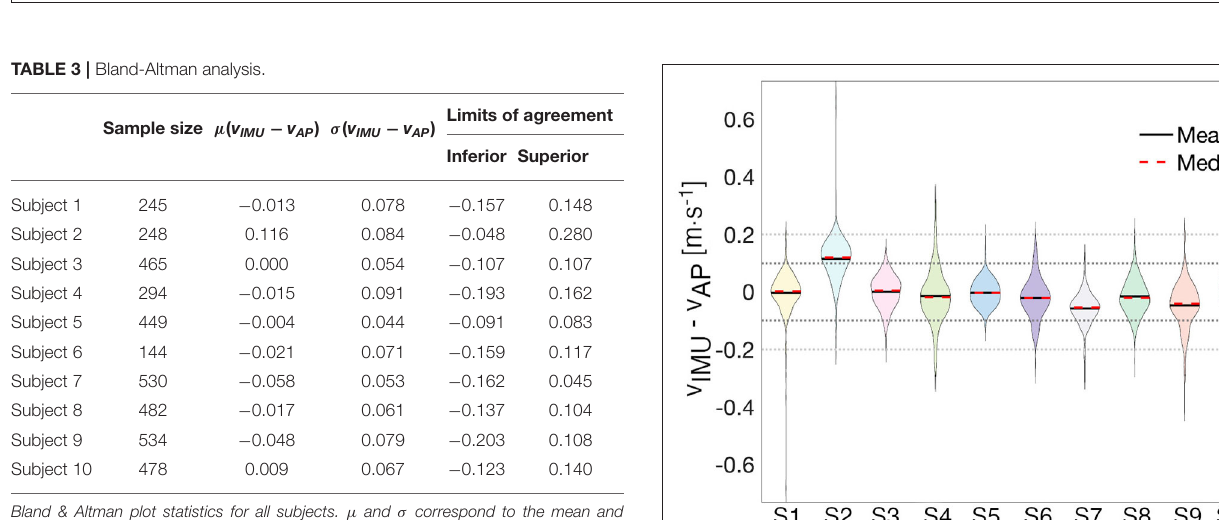
FIGURE 3 | Subject 4 analysis. (A) Subject-specific data-driven map from stride frequency to stride speed built from the metronome walk. Each cloud of points corresponds to an imposed stride frequency. (B) Bland Altman analysis of the residuals with mean difference, limits of agreement, and their confidence intervals (CI).